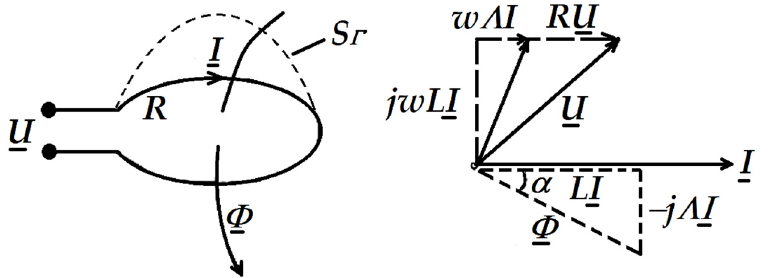
Figure A1. A circular loop carrying a current I and the magnetic flux passing through the surface S Γ ( left ); the magnetic flux, Φ , is out of phase with the current by the angle α , which increases with frequency ( right ) [42].